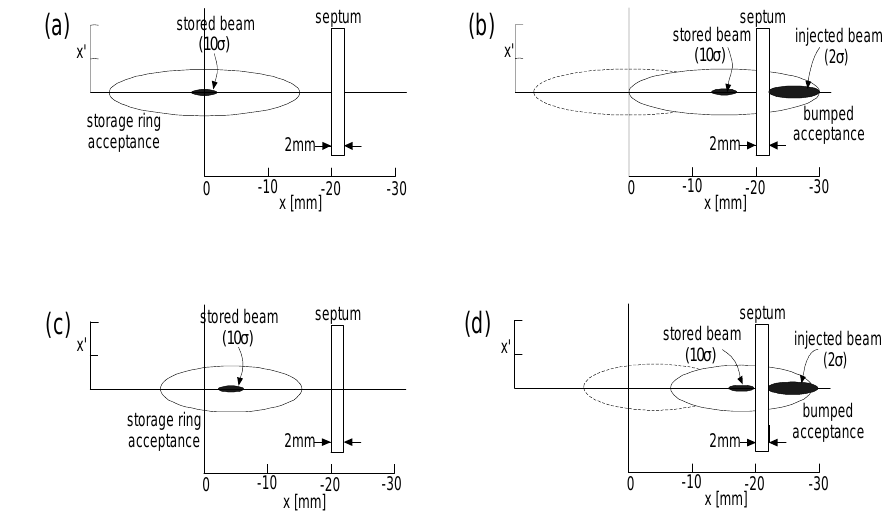
FIG. 7. Injection process: (a) before injection with a 15 mm acceptance, (b) during injection with a 15 mm acceptance, (c) before injection with a 10 mm acceptance and a 4 mm closed orbit offset, and (d) during injection with a 10 mm acceptance and a 4 mm closed orbit offset.